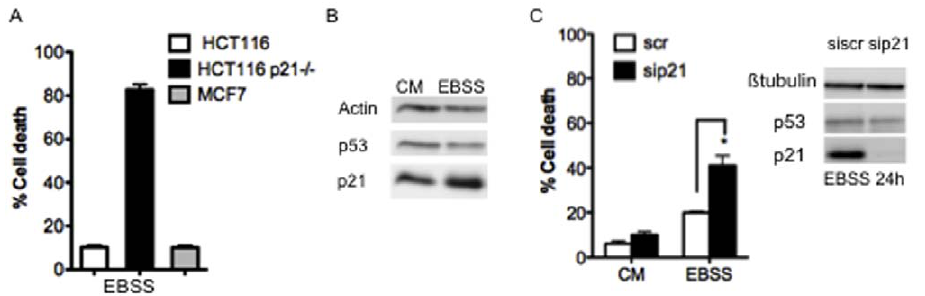
Figure 3. Survival function of p21 in the Caspase 3 deficient MCF7 cells. (A) The indicated cells were starved in EBSS medium for 24 h (EBSS) and cell death was assayed by a trypan blue-staining. (B) MCF7 cells were placed in complete medium (CM) or starved in EBSS medium (EBSS) for 24 h. Western blot analysis was performed to analyse p21 and p53 expression. (C) MCF7 cells were transfected with the indicated siRNA. 48 h later, cells were starved in EBSS medium for 24 h (EBSS) or not (CM). Western blot analysis of p21 and p53 was performed and cell death was assayed by a trypan blue-staining. Data presented in (A) and (C) are mean 6 SEM of three independent experiments.